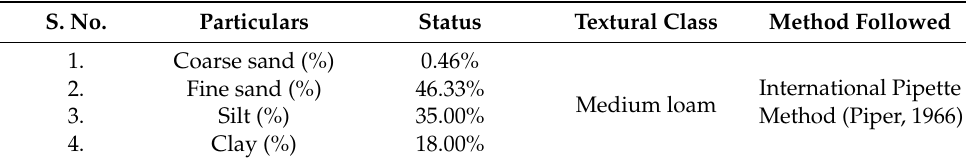
Figure 1. View of the experimental orchard. Table 1. Mechanical composition of